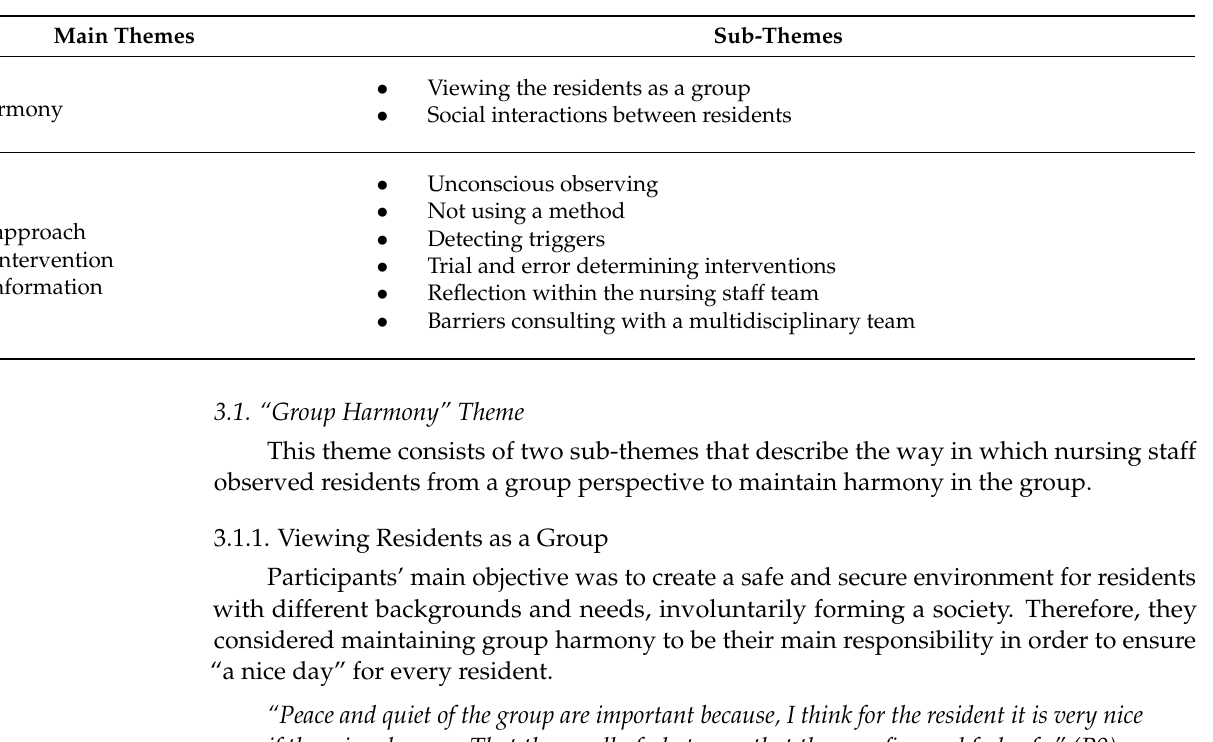
Table 3. Main themes and